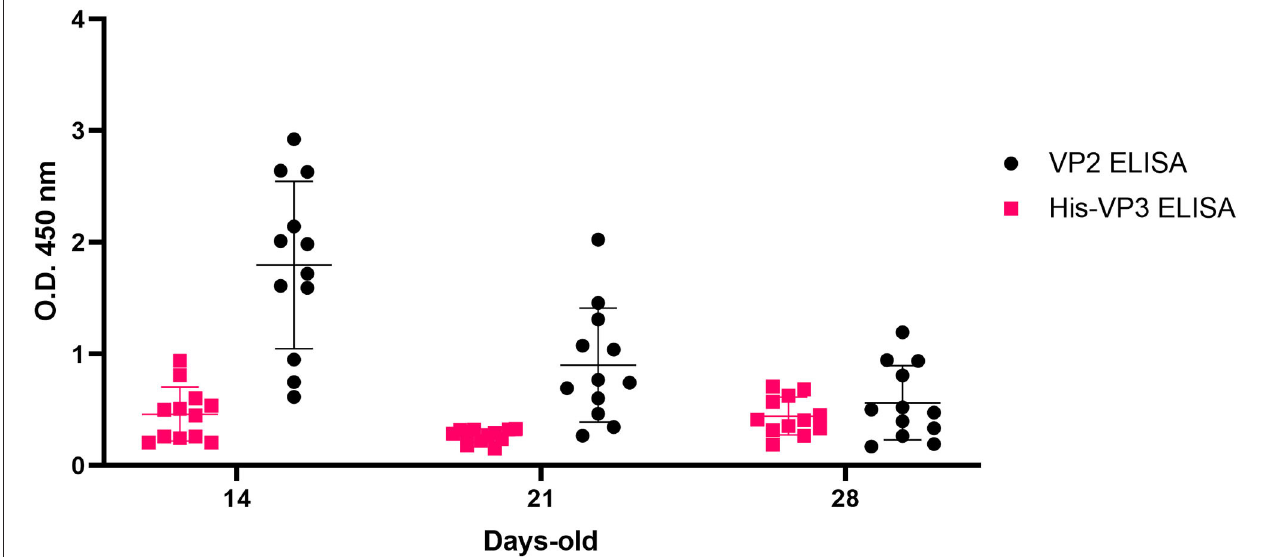
FIGURE 7 | Analysis of VP3-specific MDA in HVT-ND-IBD-vaccinated broiler chickens. Distribution of O.D. 450 values of pre-challenge Broiler-HVT-ND-IBD-vaccinated chickens sera (ID Screen® IBD VP2, black; His-VP3 ELISA, pink), collected at 14, 21, and 28 days of age. Horizontal and vertical bars: mean ± standard deviation